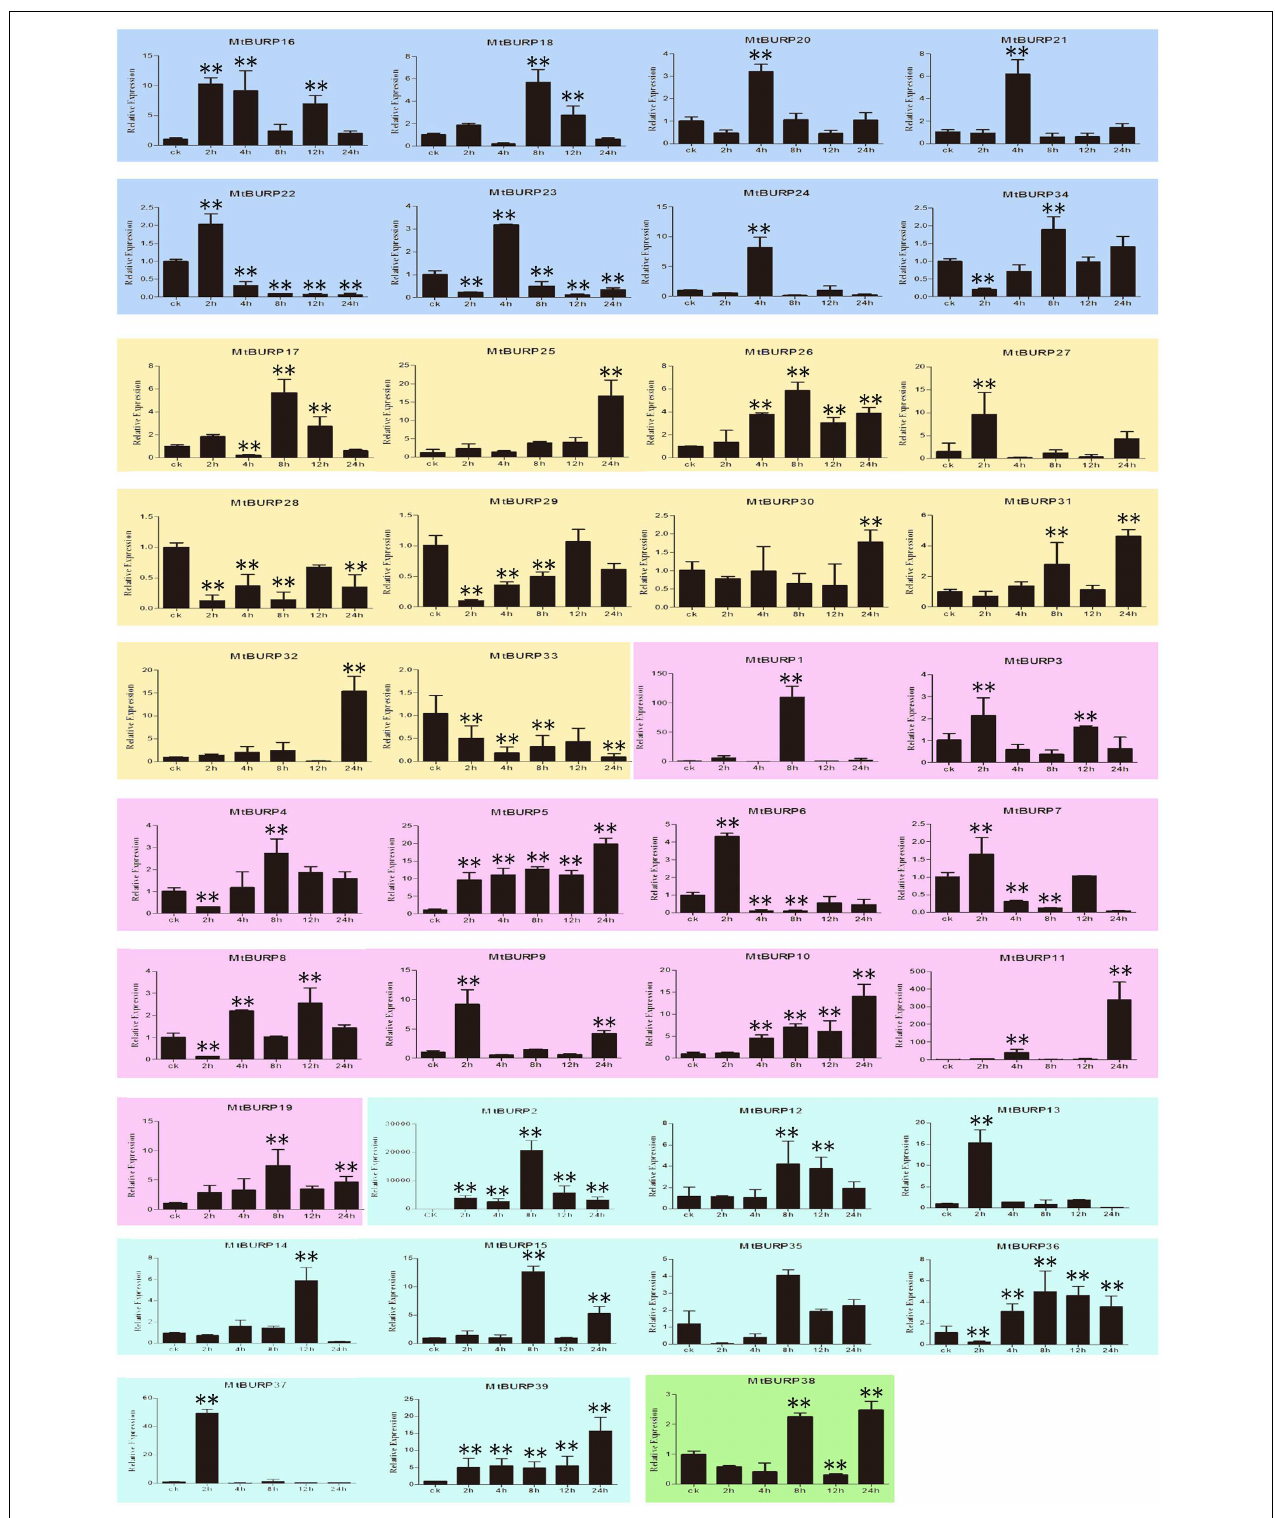
FIGURE 9 | Expression patterns of the 39 BURP genes under drought stress. Relative expressions of BURP genes were examined by qRT-PCR and normalized by SEC expression. Different subfamilies were presented in different background color. The Y axis is the scale of the relative expression level. The X axis is the time course of drought stress treatment. Mean value and SDs were obtained from three biological and three technical replicates. Two asterisks ( ∗∗ P < 0.01, Student’s t -test) represent significant differences between the controls and treatments.